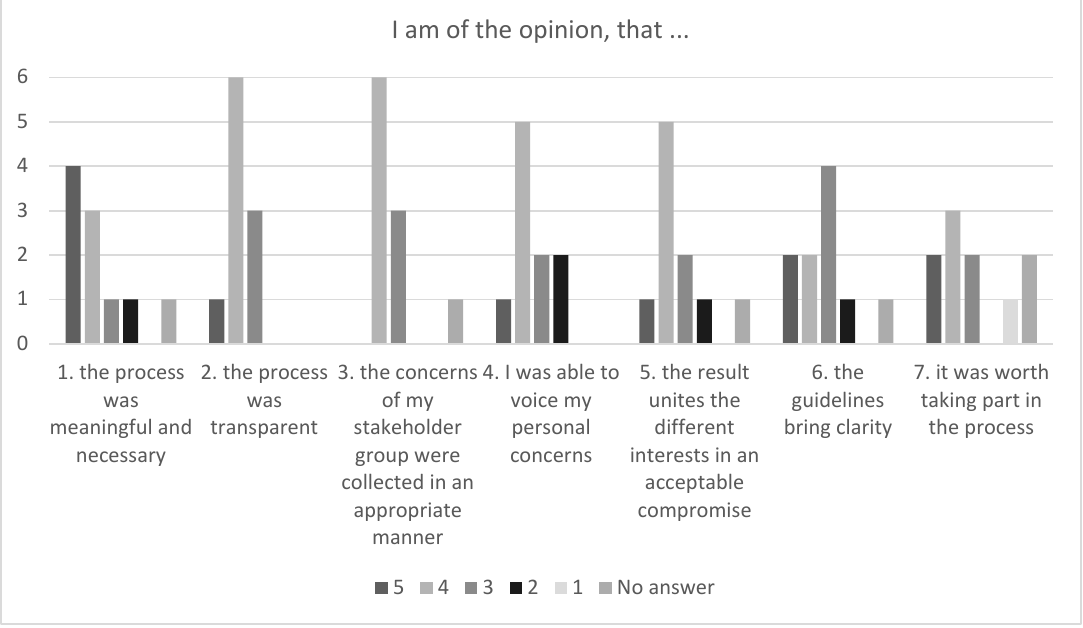
Figure 22: Results of the questionnaire distributed to participants of the final